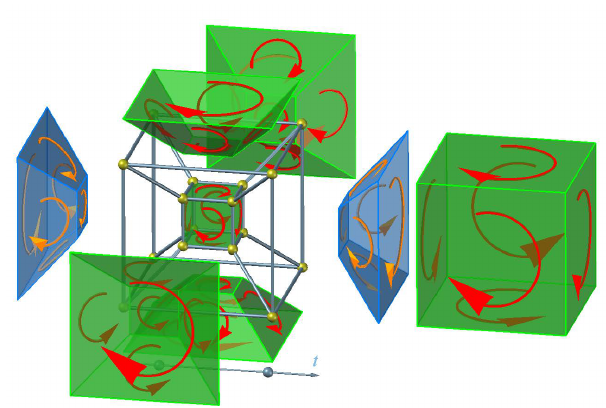
Figure 69: Inner orientations on the 2-cells of the